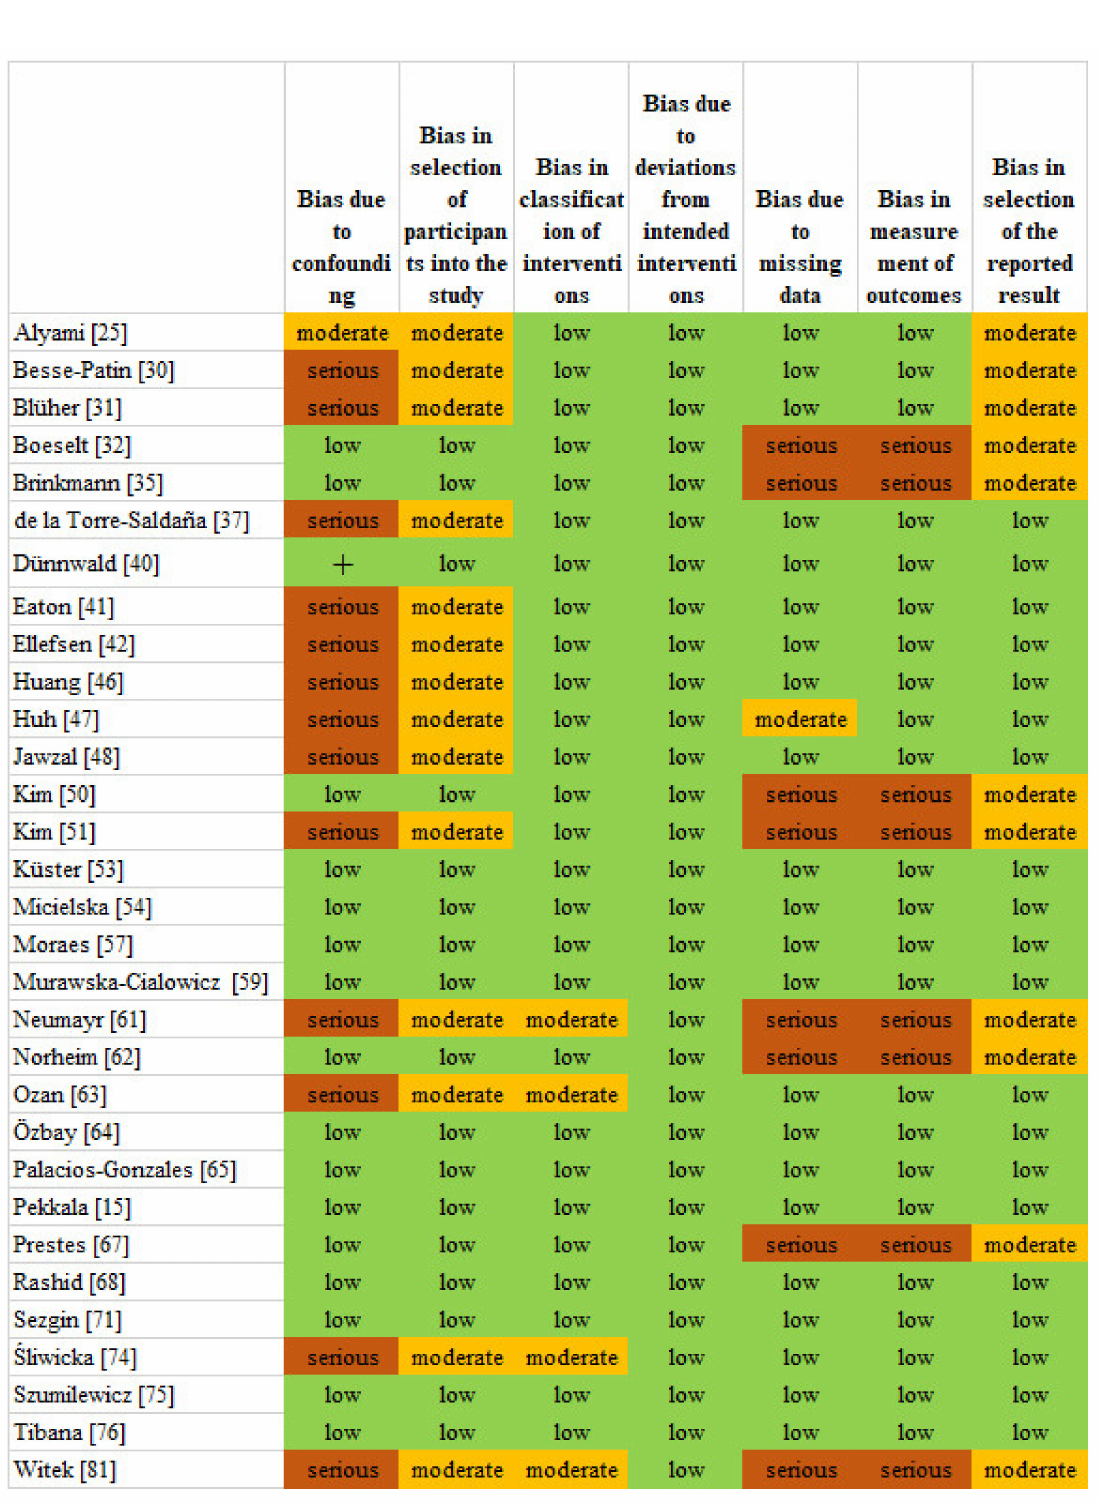
Figure 3. Risk of bias assessment using the ROBINS-I tool for non-randomized comparative